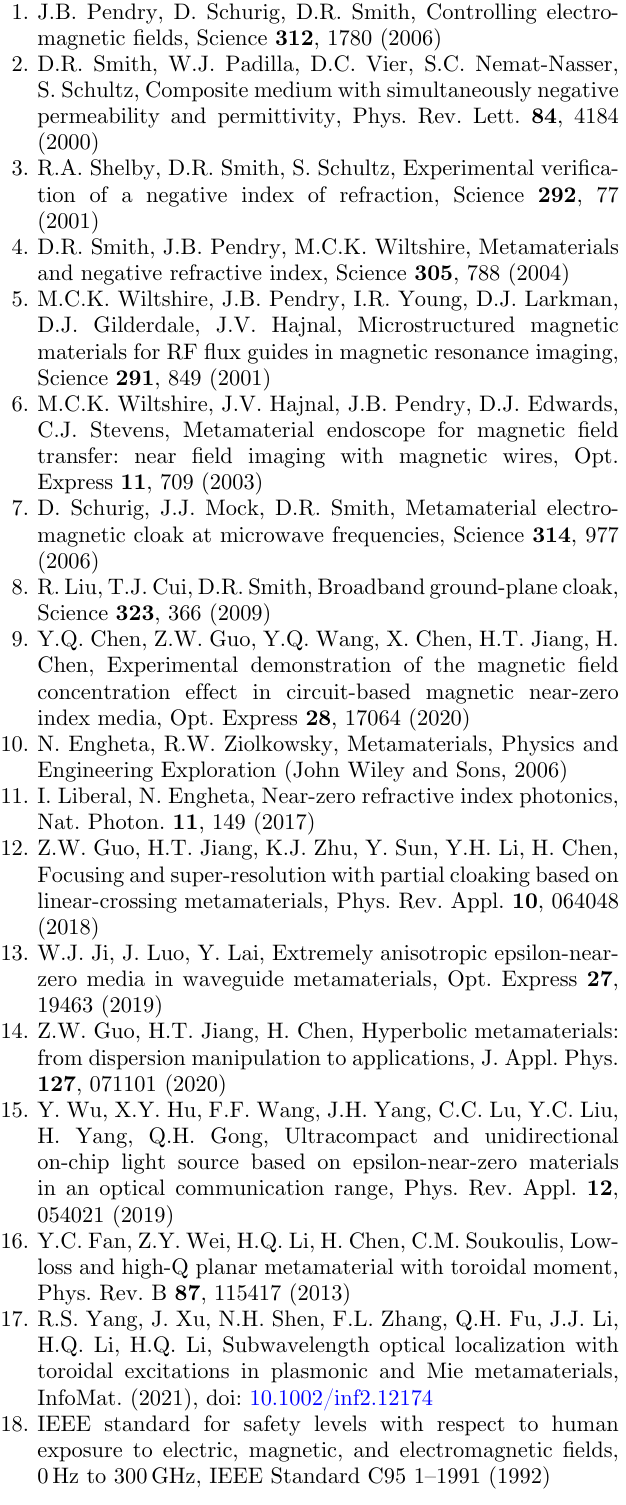
Fig. S1. The circuit diagram of metamaterial unit. Fig. S2. The permeability of the MnZn ferrite material. Fig. S3. Model diagrams of various schemes used in simulation. Fig. S4. Shielding effectiveness (SE) measured in the experiment. The distance between TX and RX is 120 mm. Table S1. The measured SE of a single ferrite slab when the distance between the Tx and Rx coils is 60 mm and the selected frequency is 82.94 kHz. Table S2. The measured SE of a single ferrite slab when the distance between the Tx and Rx coils is 150 mm and the selected frequency is 82.25